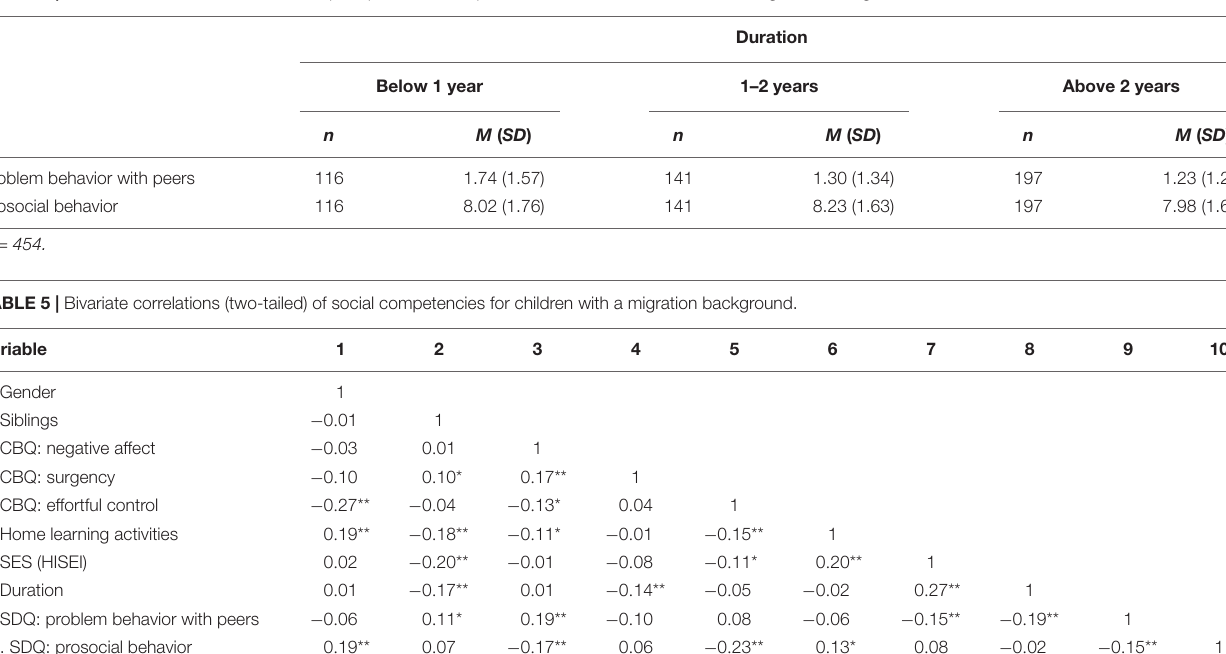
TABLE 4 | Means and standard deviations for peer problems and prosocial behavior of children with a migration background.